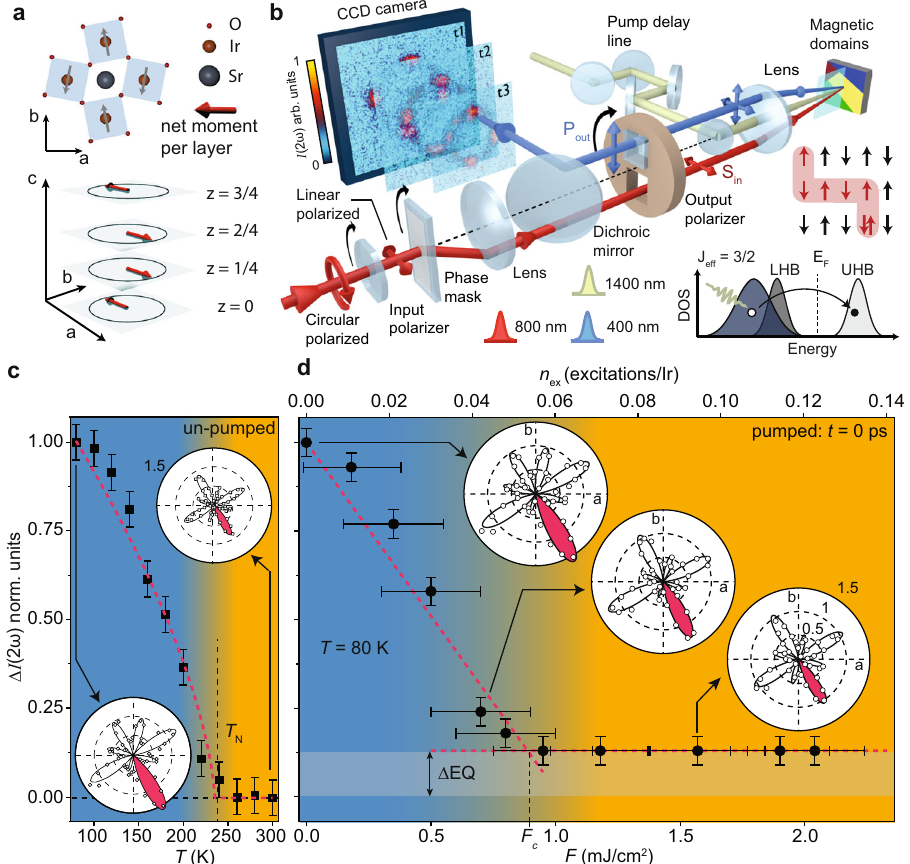
Fig. 1 Instantaneous photo-doping response of magnetic order in Sr 2 IrO 4 . a Schematic of an IrO 2 layer (O: red; Ir: orange; Sr: gray spheres). Azure squares represent the ab -plane projection of the IrO 6 octahedra and gray arrows represent the J eff = 1/2 pseudospins. Each IrO 2 layer, shown as blue planes at z = 0, 1/4, 2/4, 3/4, with z the fractional coordinate along the c -axis, possesses a net moment (red arrow) due to pseudospin canting, which is staggered along the c -axis. b Schematic of the time-resolved second harmonic generation rotational anisotropy (SHG-RA) setup (See “ Time-resolved spectroscopic probes ” ). Wavelengths of the pump pulse and incident and SHG probe pulses are color-coded. Curved black arrows indicate co-rotating optical elements. Data shown throughout the manuscript are acquired in the P in -S out polarization channel. Different colors on the sample represent distinct magnetic domains. Inset: schematic of n -type photo-doping and resulting doublon generation and propagation through the antiferromagnetic lattice (red line). DOS density of states, LHB (UHB) lower (upper) Hubbard band, E F Fermi energy. c Temperature dependence of the change in SHG intensity Δ I (2 ω ) relative to T = 300 K for an un-pumped sample acquired at the angle of maximum intensity (red shaded lobe in the SHG-RA plots). The red dashed line is a guide to the eye and the vertical dashed line marks the Néel temperature ( T N ). Vertical error bars represent the range of intensity values obtained upon selecting different regions of the CCD camera for radial integration and background subtraction in order to convert raw data into SHG-RA intensity patterns. d Pump fl uence dependence of Δ I (2 ω ) at t = 0 and T = 80 K with corresponding SHG-RA patterns (white circles). Fits to the data below (above) F c including both electric-quadrupole (EQ) and surface magnetization-induced electric-dipole (SMIED) terms (solely EQ term) are overlaid (black lines). Height of the gray bar represents the change in EQ SHG intensity with respect to the equilibrium value as discussed in the main text. Horizontal error bars represent an upper bound on the uncertainty in the calculation of n ex assuming F = 2 mJ/cm 2 (as described in “ Conversion from F to n ex ” ). The SHG-RA intensities are normalized to the T = 300 K value (circular grid